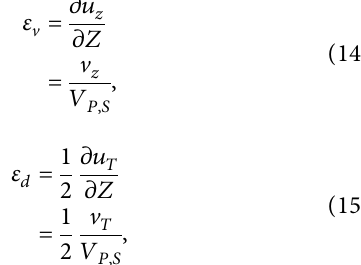
calculated water level changes were fitted. The results are listed in Table 2. When assuming only volumetric strain, correlation coefficient of R 2 � 0.675 for the Solomon Islands � 12.364 GPa with a earthquake (Figure 3(a)) and BK u correlation coefficient of R 2 � 0.001 for the Kaik � oura earthquake (Figure 3(b)). When assuming only deviatoric strain, N � 17.363 GPa with a low correlation coefficient value of R 2 � 0.258 for the Solomon Islands earthquake (Figure 3(c)) and N � 2.529 GPa with R 2 � 0.557 for the Kaik � oura earthquake (Figure 3(d)). The relatively smaller R 2 value for the former indicated that only the volumetric or the changes in the pore pressure. When considering both the volumetric strain and the deviatoric strain, N � 8.437 GPa with R 2 � 0.728 (Solomon Islands earthquake) (Figure 3(e)) and BK u ( 1 − 2 v u )( 1 − v u ) � 1 . 439 GPa, � 3.717 GPa, and N � 2.529 GPa with R 2 � 0.560 BK u (Kaik � oura earthquake) (Figure 3(f)). The best correlation coefficient between the calculated and measured water pressure showed that the changes in the pore pressure were influenced by both the volumetric strain and the deviatoric strain.